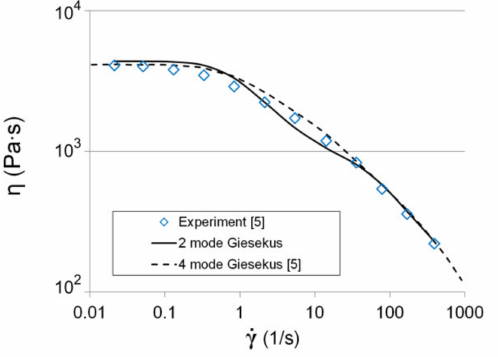
Figure 2. Viscosity curve: experiment and fitting with two and four-mode Giesekus model.